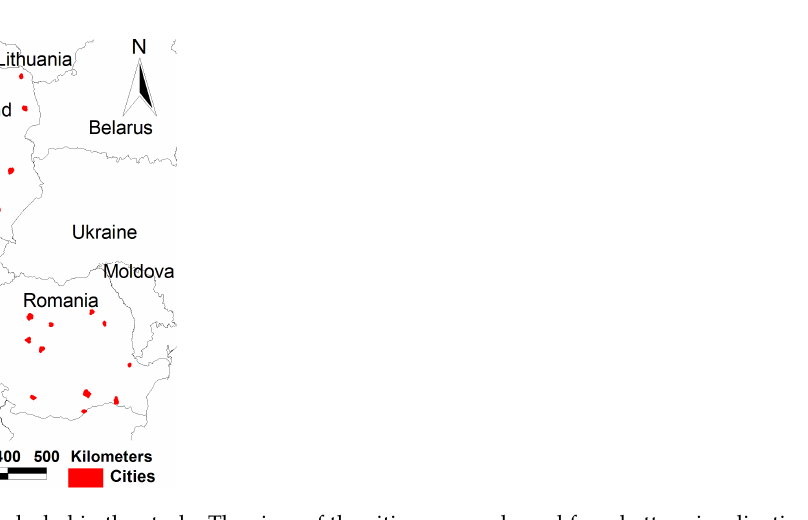
Figure 2. Cities included in the study. The sizes of the cities were enlarged for a better visualization of their position.